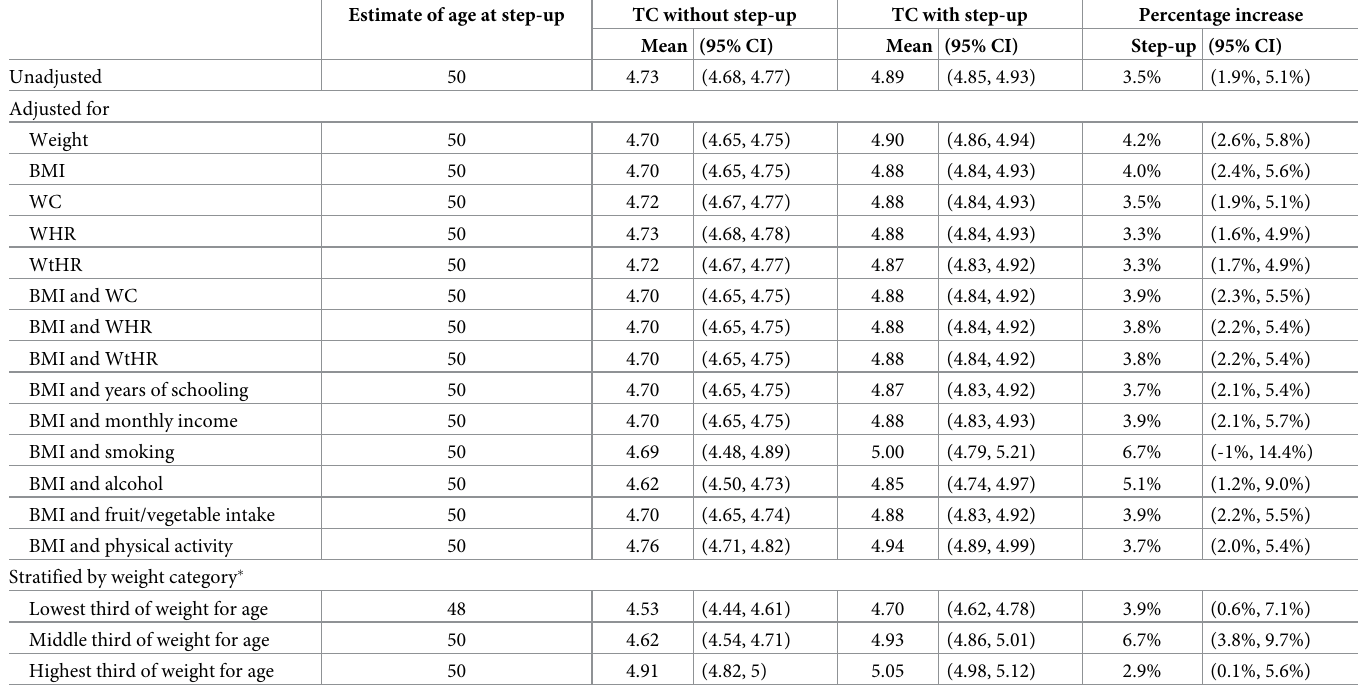
Table 3. Estimates of the step-up in the mean value of TC occurring at around 50 years of age for women in